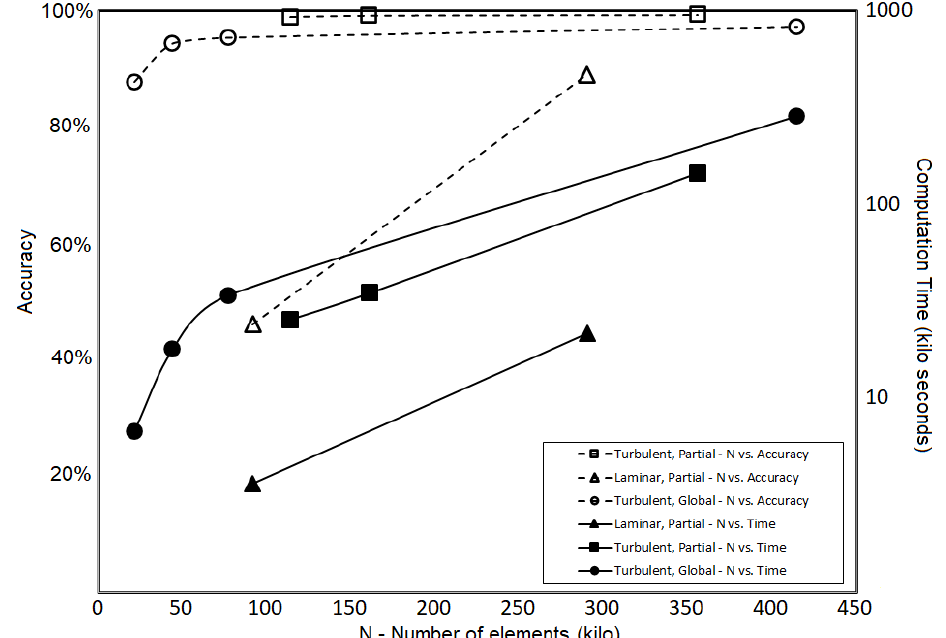
Figure 5. Convergence studies—data with dark labels indicate relationship between number of mesh and computation time, while the white markers indicate the relationship between the number of mesh and accuracy. The Laminar model shows the lowest accuracy and computing time. The Turbulent models can take 10 times longer time than the laminar flow, but its accuracy is very